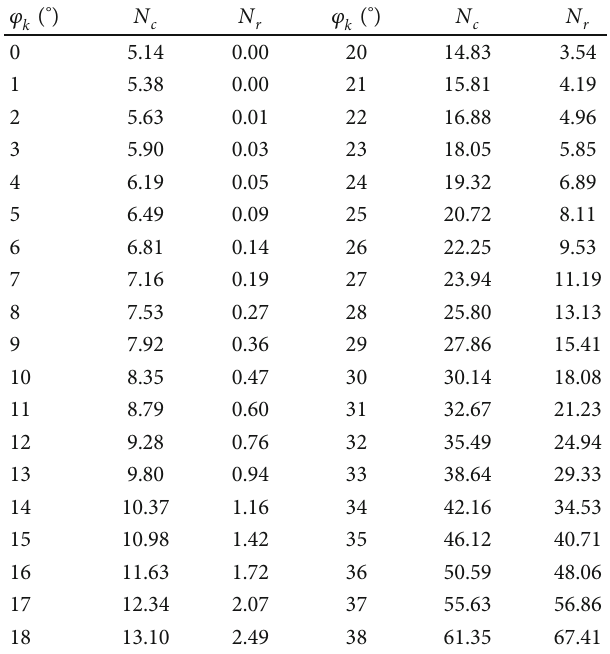
Table 3: Foundation bearing capacity coe ffi of ak